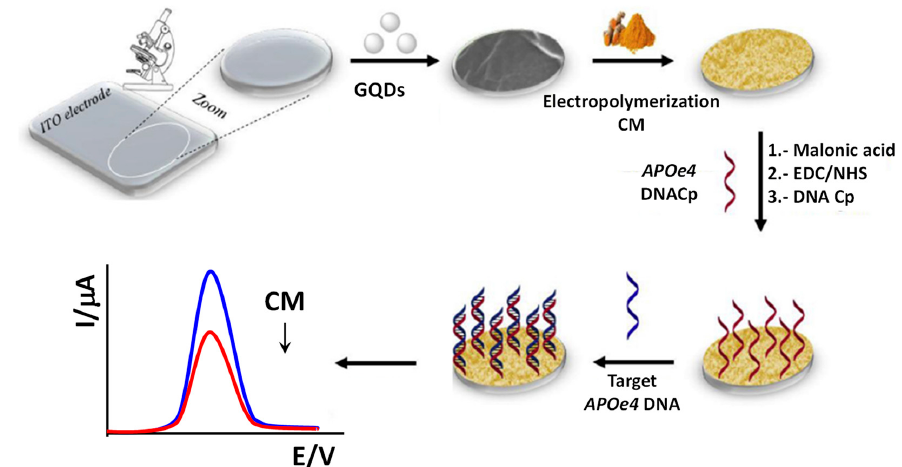
Figure 6. Schematic representation of the electrochemical DNA biosensor developed to sense Alzheimer’s and artery coronary diseases using CM / GQDs as surface modifier of the ITO electrode. Reproduced and adapted with permission from [58]. Copyright Elsevier, 2018.